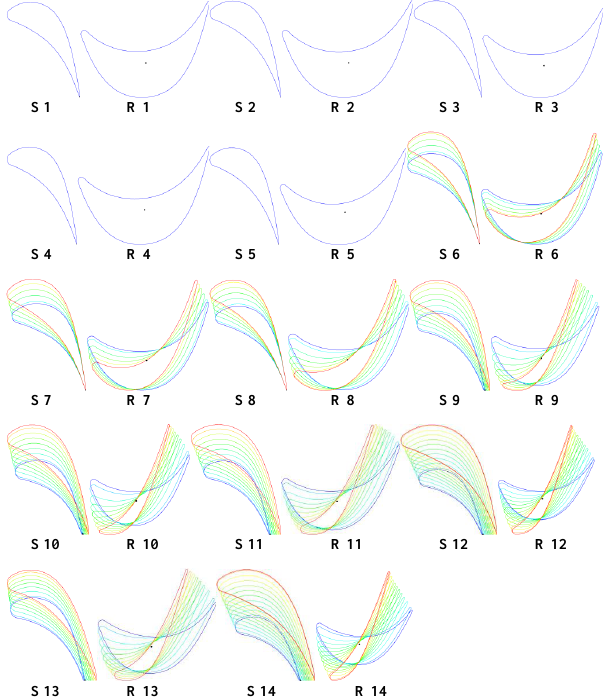
Figure 22. Blade profiles of the newT-125/150-12,8 CMP turbine Figure 22: Blade profiles of the newT-125/150-12,8 CMP We can see from Fig. 23 and Table. 4 that all stages of a new construction have a higher efficiency. The total efficiency of the proposed construction, not including humidity losses is estimated at 92.3%, and with humidity losses - 90.1%. Visualization of the results in the middle blade-to-blade sections presented in Fig. 24 exhibits favorable flow patterns. Using new smooth profiles leads to a more monotonous static pressure distribution on the blades